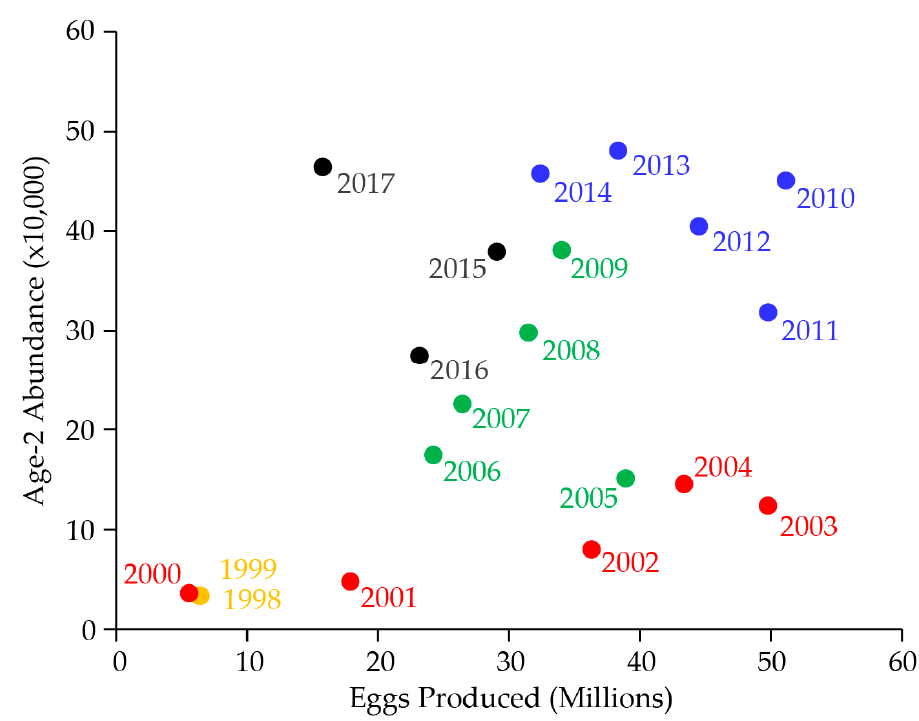
Figure 11. Age-2 lake trout abundances during 1998 to 2017 and estimates of the number of spawned eggs that produced these recruits two years previously estimated by a statistical catch-at-age (SCAA) assessment model [81]. Different colors represent 5-year periods of the lake trout suppression program described in text. Although fewer eggs were produced annually since lake trout population growth was curtailed in 2012, similar (or often greater) abundances of age-2 lake trout were recruited to the population, suggesting a compensatory response.